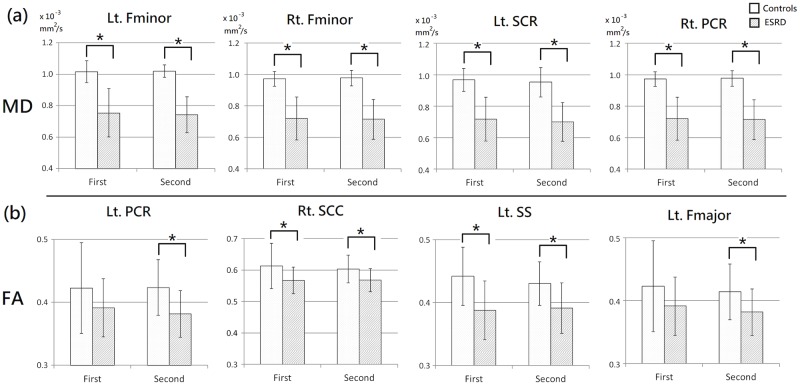
Comparisons of DTI indices between ESRD patients and healthy controls in significant regions of interaction analysis.In the significant regions, MD (a) and FA (b) values were significantly higher in healthy controls than in ESRD patients. Asterisks (*) indicate statistical significance (P < 0.05). Fmajor = forceps major; Fminor = forceps minor; SCC = splenium of corpus callosum; SCR = superior corona radiata; PCR = posterior corona radiata; SS = sagittal stratum; Lt. = left; Rt. = right.